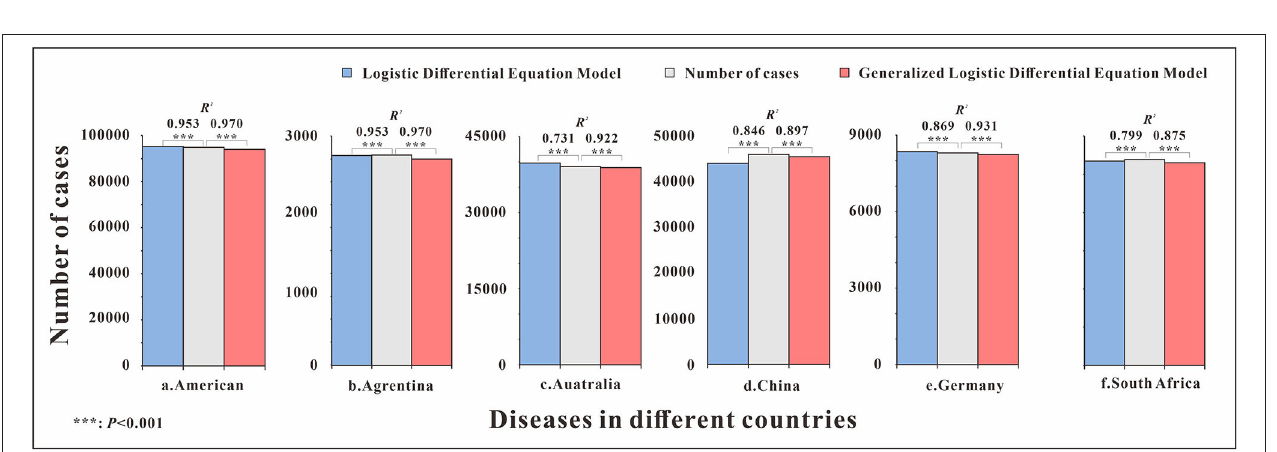
FIGURE 5 | Curve fitting results of logistic and generalized logistic differential equation models in different areas. (a) American, (b) Argentina, (c) Australia, (d) China, (e) Germany, and (f) South Africa.